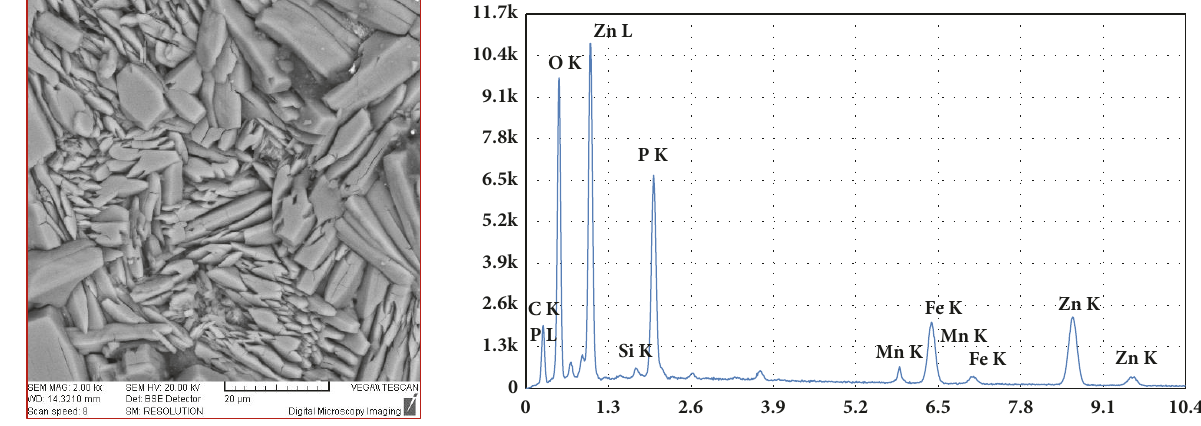
Figure 8: SEM and EDX of ZnP-Mn coating.